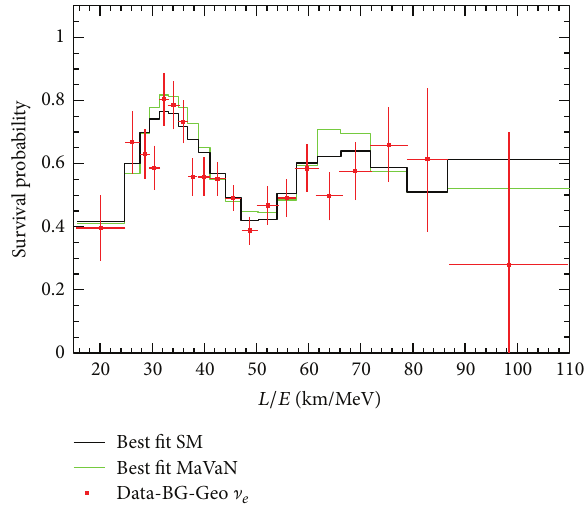
Figure 5: Ratio curve of the survival probability of survival with the caseofnooscillation.Wecomparedtheexperimentaldata(red)with the description of the standard model (black) and the obtained for the MaVaN model (green).